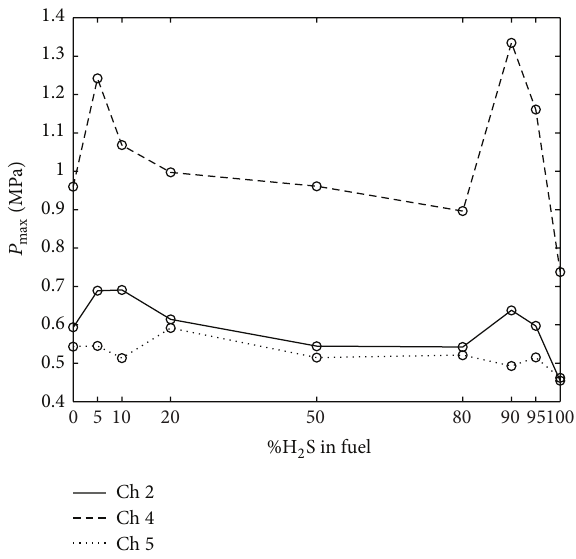
Figure13:Maximumpressurefromexperiments.Thepressurefrom channels 2, 4, and 5 for various H 2 S contents in the fuel.